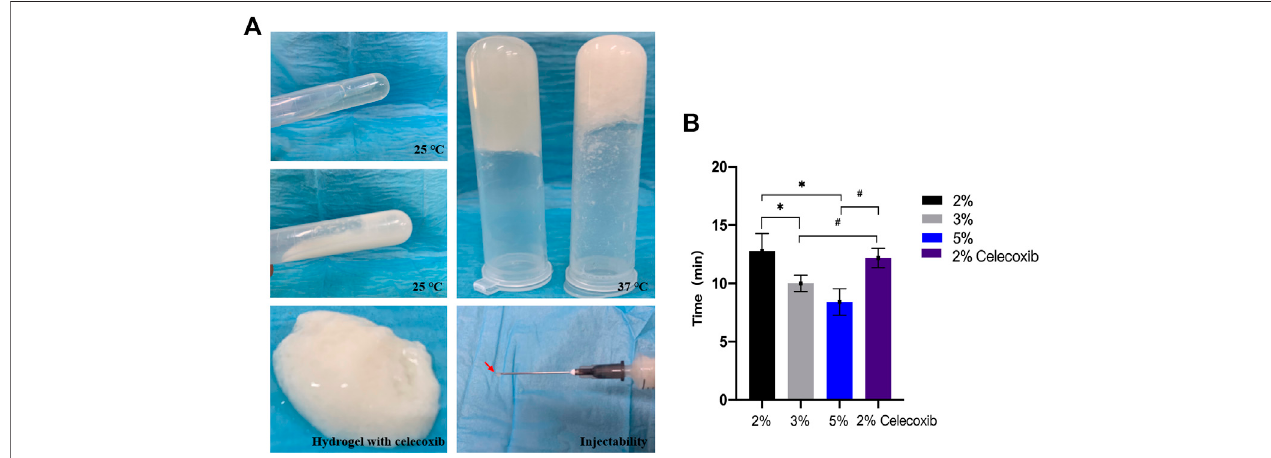
FIGURE 2 | (A) Photographs of in situ gel formation of 2 wt% hydrogels (upper left) and hydrogel with celecoxib (middle left) solution with temperature increased from 25 ° C to 37 ° S (upper right), gel stability (below left), and injectability (below right). (B) The thermosensitive sol-gel conversiontimeof hydrogel solutionswithdifferent concentrations. (*,# = p <